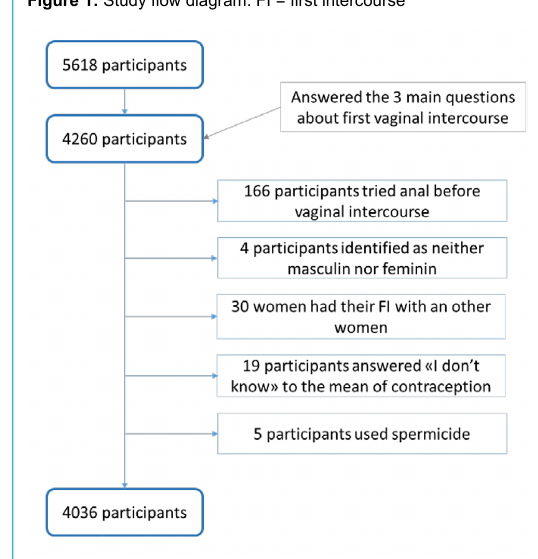
Figure 1: Study flow diagram. FI = first